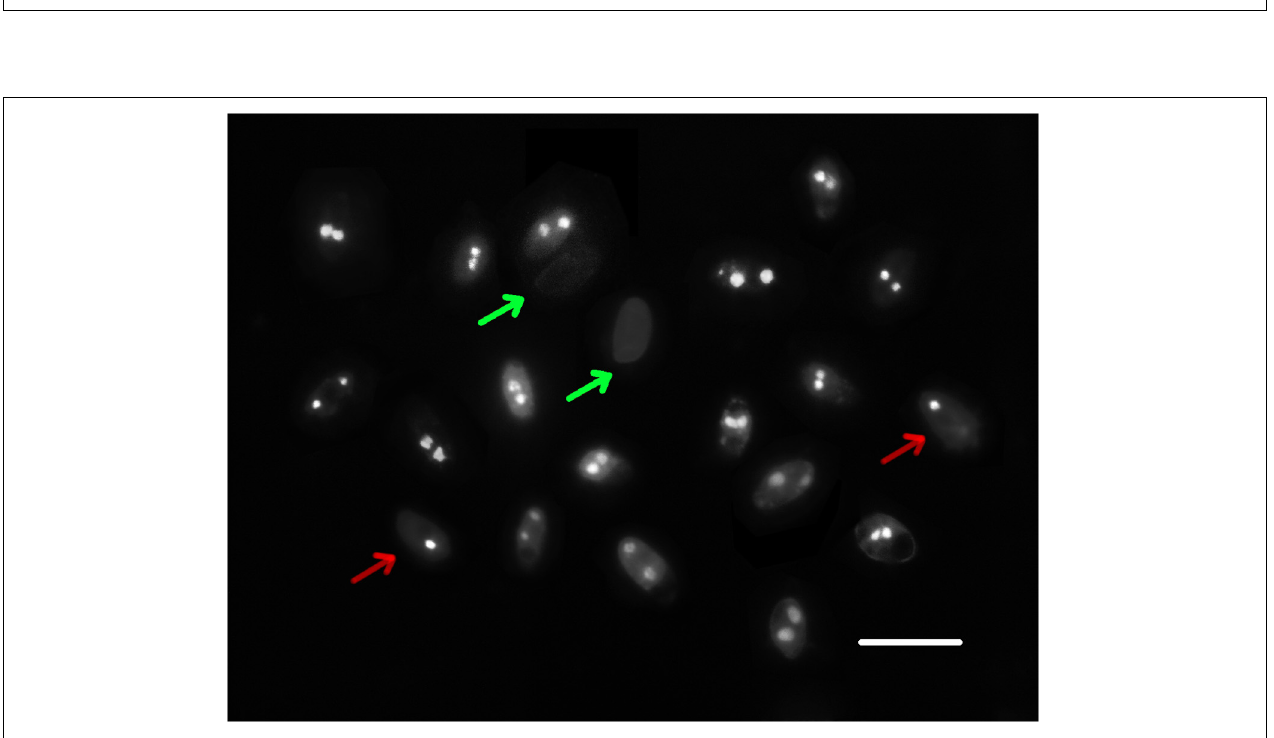
FIGURE 2 | Nuclei of basidiospores of strain CGMCC 5.545. The red arrow indicates uninucleate spores, the green arrow indicates nuclear-free spores, and the others are binucleate spores. Scale bar: 10 µ m.